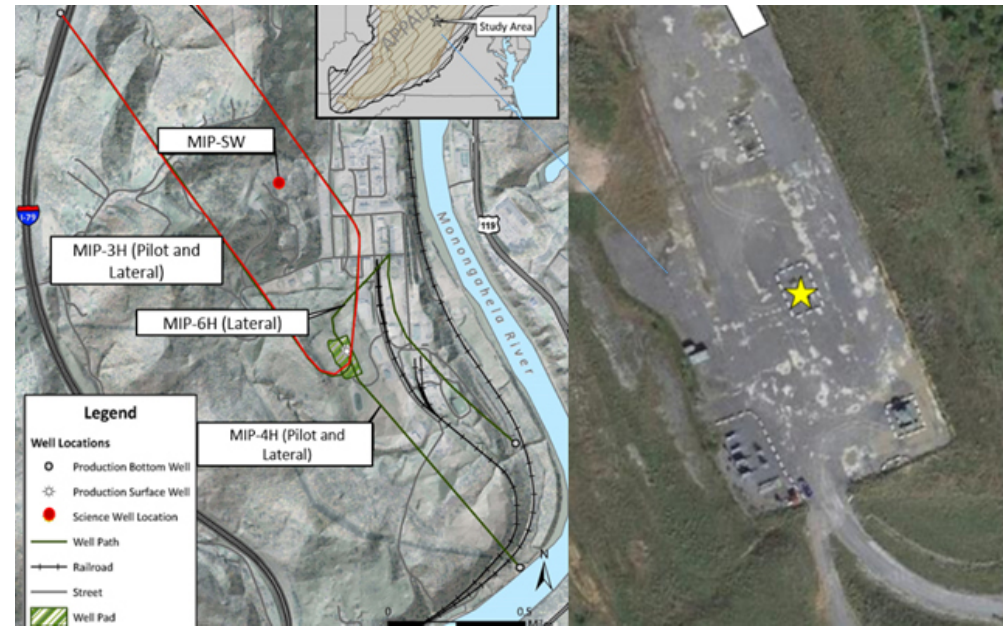
Figure 1. Location of the Marcellus Shale Energy and Environment Laboratory and the four production wells.